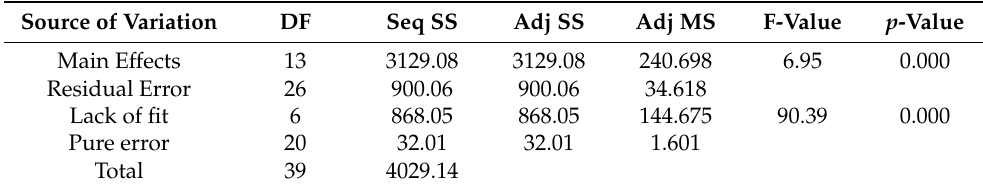
Table 4. Analysis of variance for the phycoerythrin